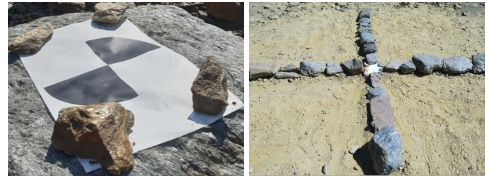
Figure 2. Artificial and natural targets.